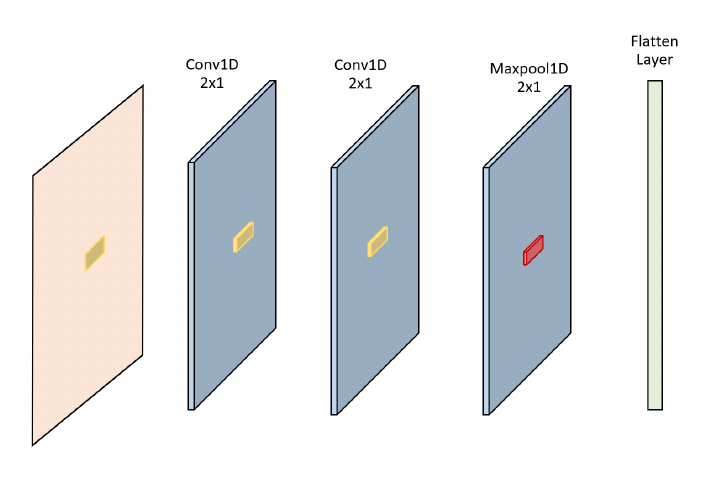
Figure 5. Convolution and maxpool Layers for univariant CNN.